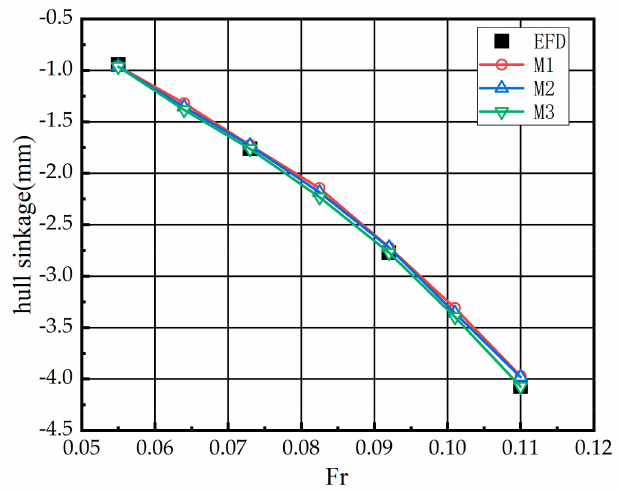
Figure 5. Mesh convergence for numerical simulations of hull sinkage.